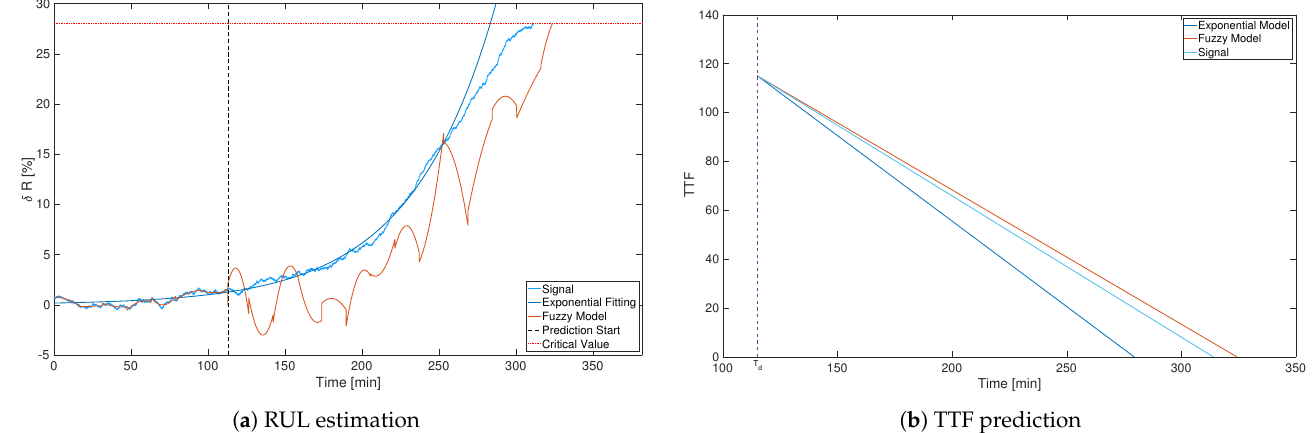
Figure 15. RUL and Time-To-Failure (TTF) analysis of the 36th MOSFET after 35% of its real lifetime.